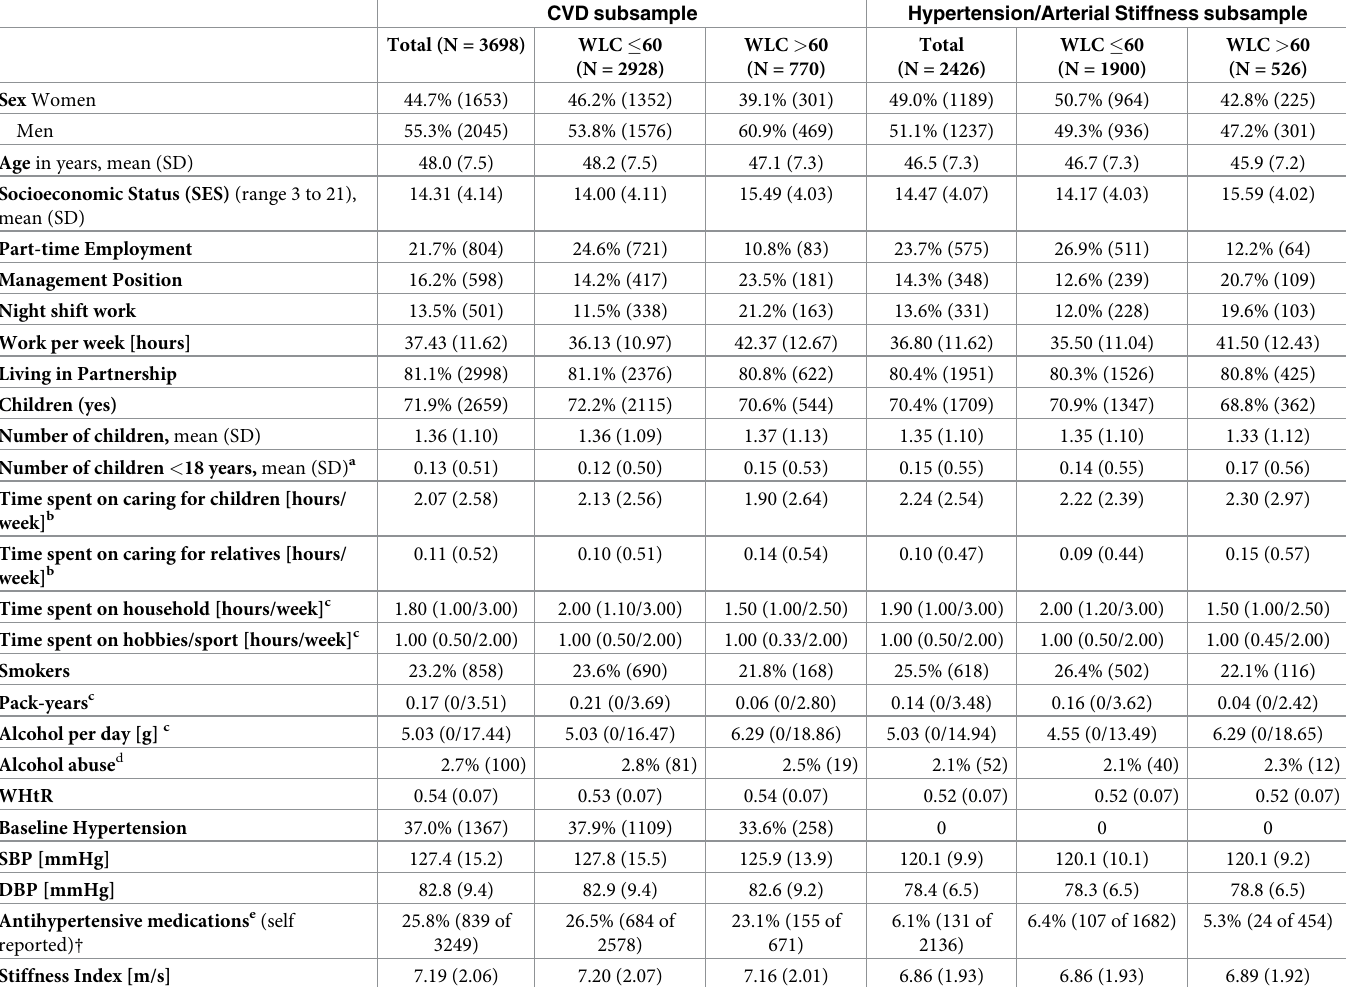
Table 1. Population characteristics at